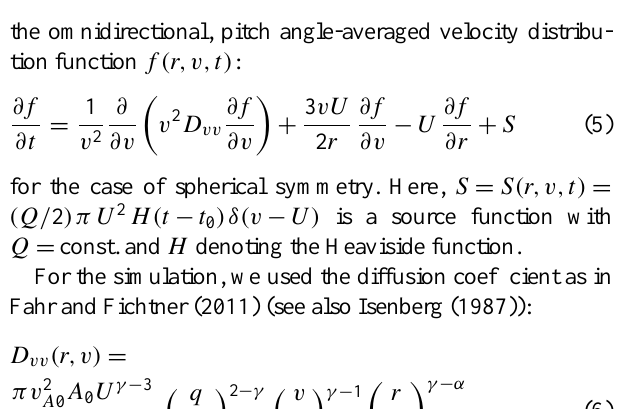
Fig. 4. The (normalized) PUI velocity distribution f 2 U 2 r/ 3 Q as a function of normalized PUI speed and heliocentric distance (and, thus, of time): From bottom to top the curves are for r = 1.2, 1.6, 2.0, 4.0, 8.0 and 29 AU using the velocity diffusion coefficent given in Eq.(6) with the modification described with Eq.(3).